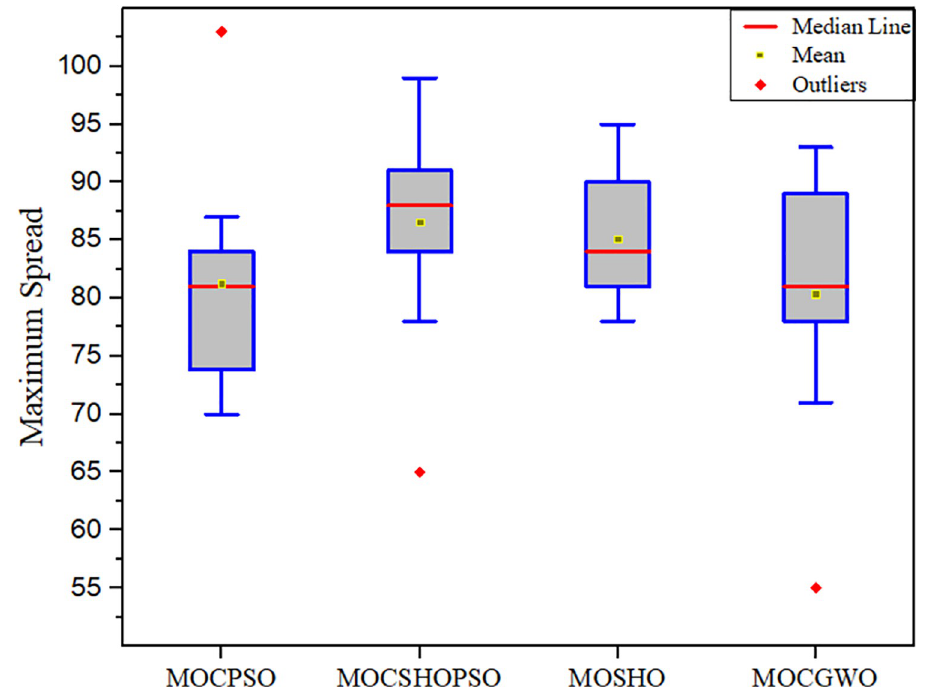
Fig 7. Box plot, driven from the maximum spread comparison.